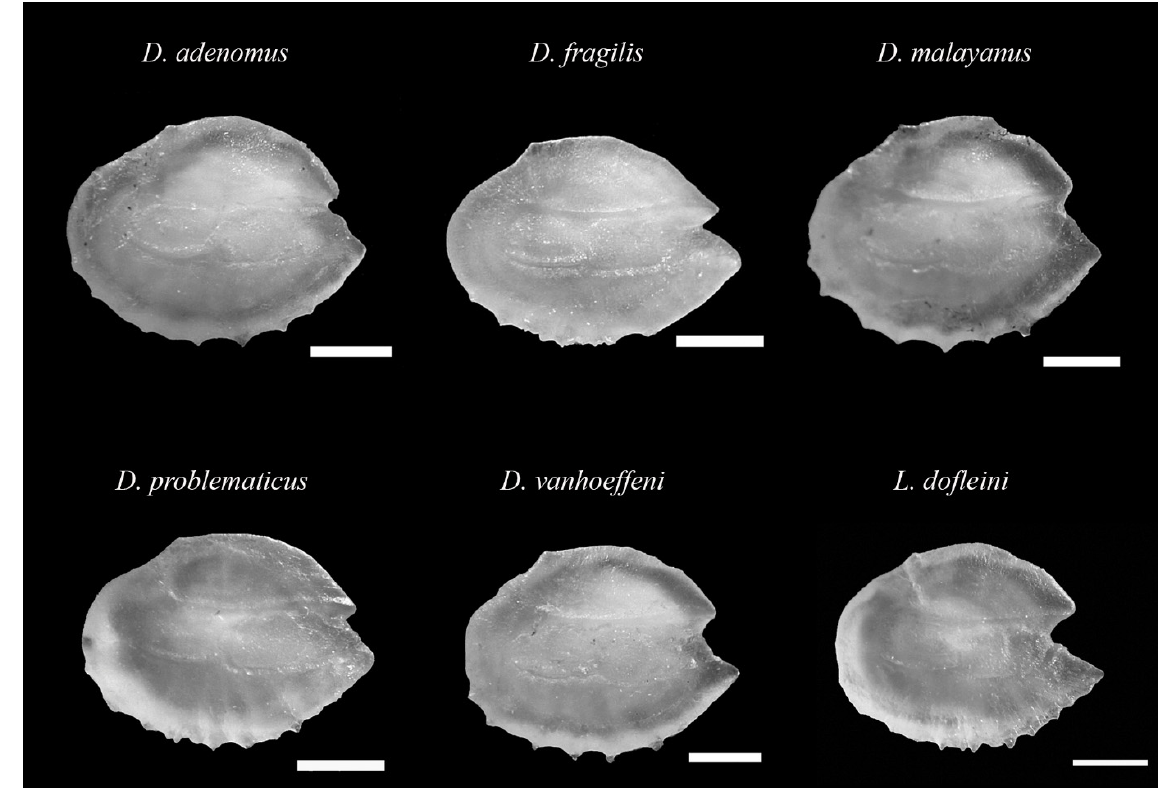
Figure 3. Morphology of otoliths extracted in the mesopelagic fish species collected along the south ‐ east coast of Gran Canaria.